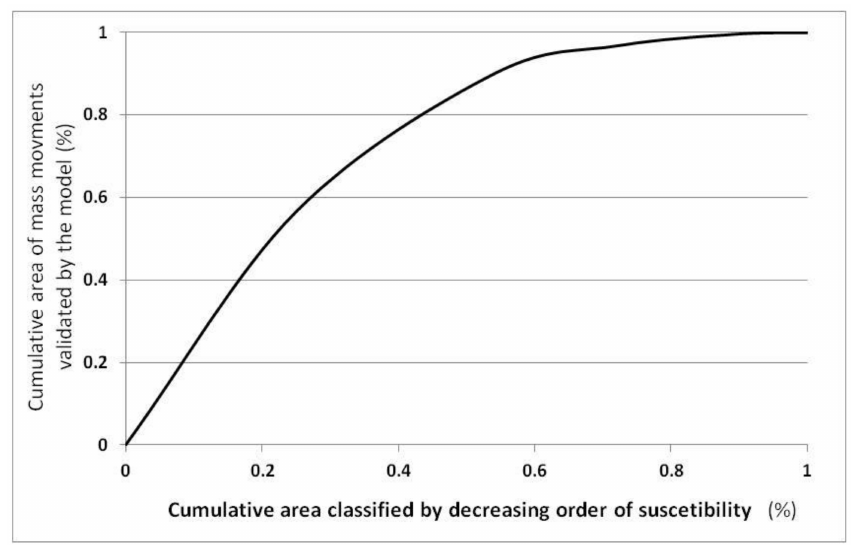
Figure 5. Predicted curve of the mass movements susceptibility map, applied to Funchal